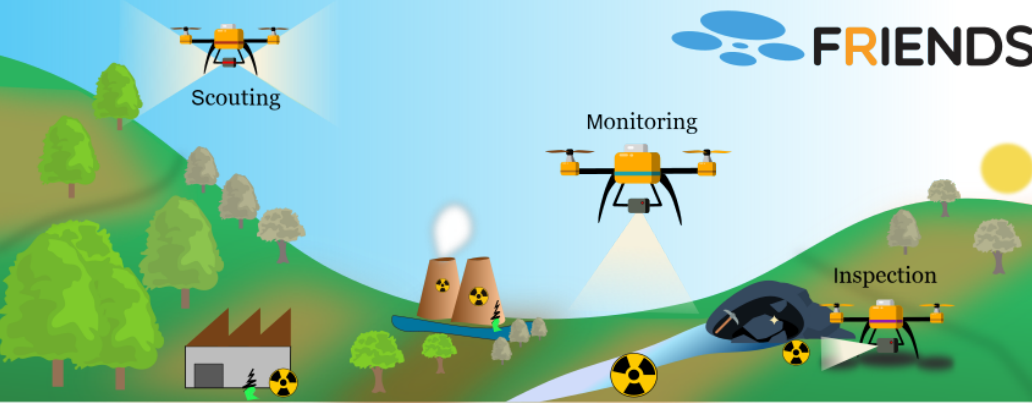
Figure 1. The FRIENDS mission is focused on three